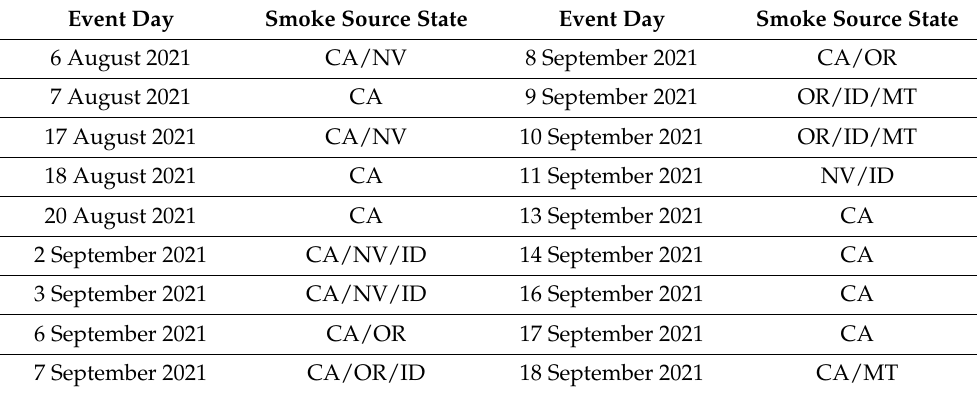
Table 2. The August and September event days where the smoke plumes output by a wildfire make their way to our region. The California wildfires were mainly in the north part of the state. The HRRR reported the plumes as PM 2.5 in micrograms per cubic meter through a color-coded volume. Most of the fires lasted for a couple of days.